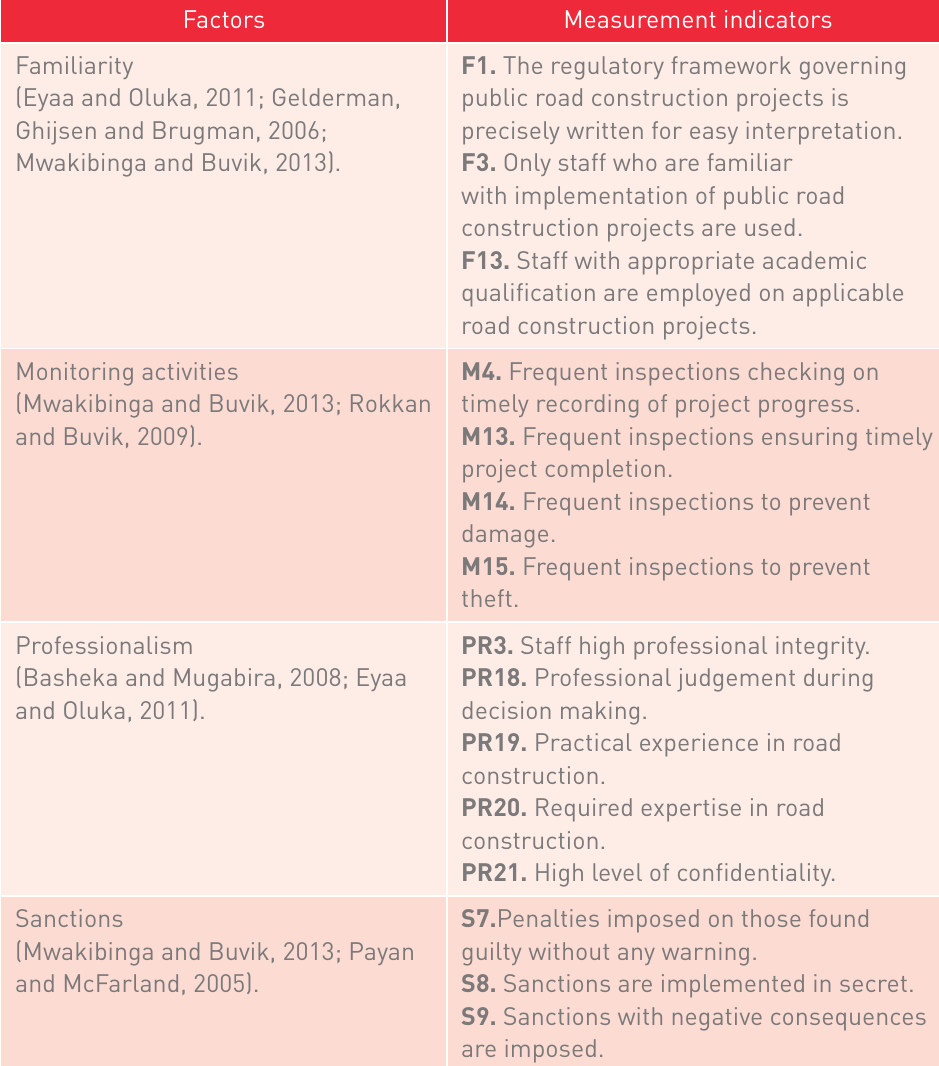
Factors that Affect Compliance and Measurement